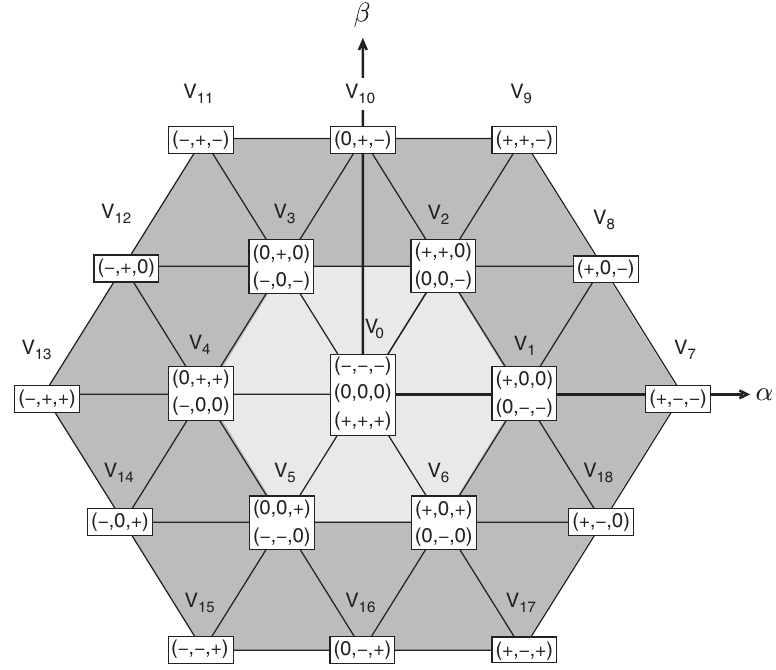
Figure 4. Switching states and voltage vectors of the three-phase T-type inverter.